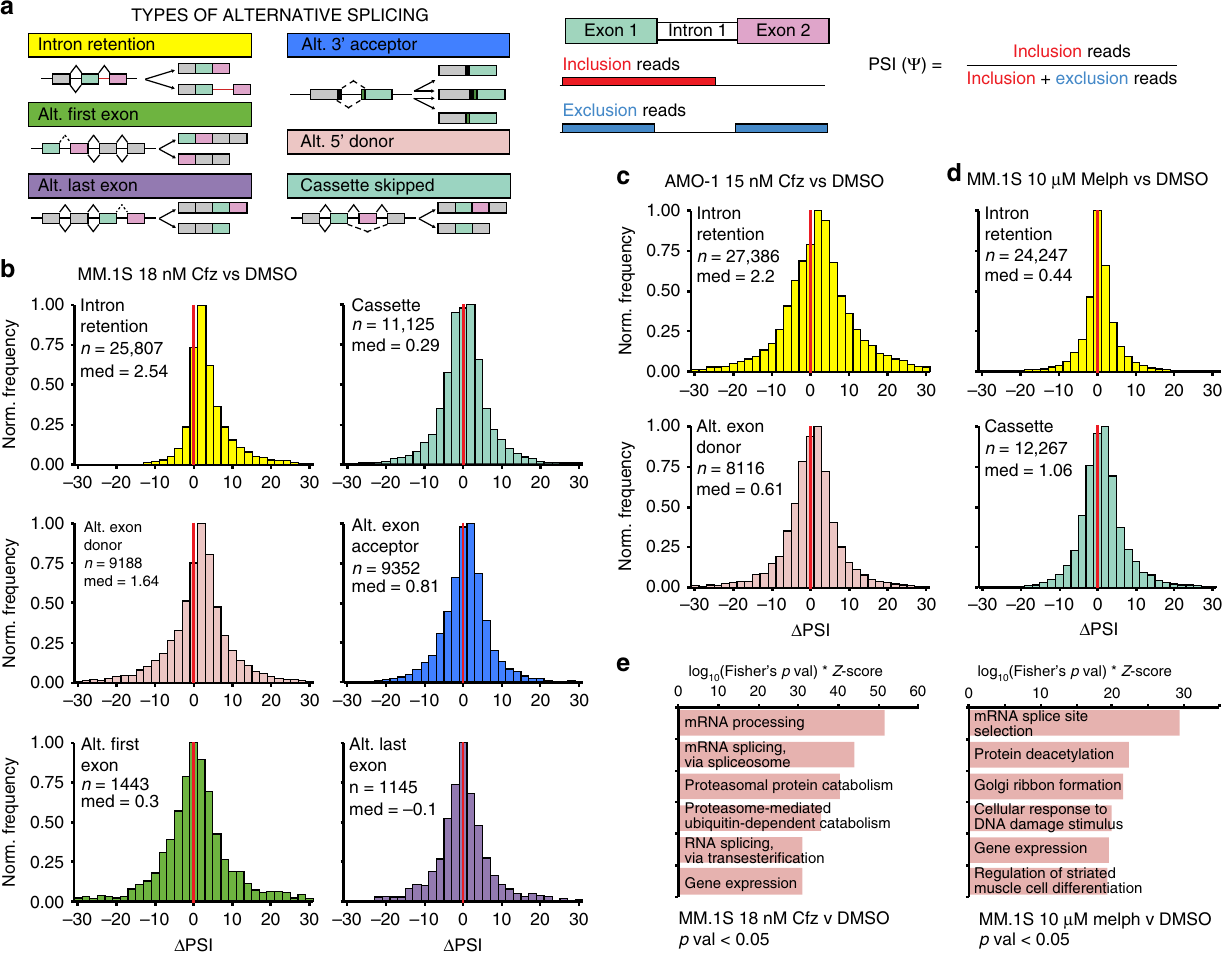
Fig. 3 Cfz treatment leads to prominent intron retention. a Cartoon description of alternative splicing event (ASE) types and description of Δ PSI. b Histograms of Δ PSI for JuncBASE identi fi ed ASEs in MM.1S treated with 18 nM Cfz strati fi ed according to type of splicing event (IR = yellow, alt. exon cassette = teal, alt. exon donor (5 ’ splice site) = pink, alt. exon acceptor (3 ’ splice site) = blue, alt. fi rst exon = green, alt. last exon = purple). Bin = 2, red line indicates Δ PSI = 0. c Histograms of Δ PSI for all IR events (top panel) and Alt. exon donor events (bottom panel) in AMO-1 treated with 15 nM Cfz. d Histograms of Δ PSI for all IR events (top panel) and Alt. cassette events (bottom panel) in MM.1S treated with 10 μ M melphalan. e Top ranked GO enrichment terms for genes with signi fi cant ( p < 0.05) ASEs for MM.1S cells treated with 18 nM Cfz (left panel) or with 10 μ M melphalan (right